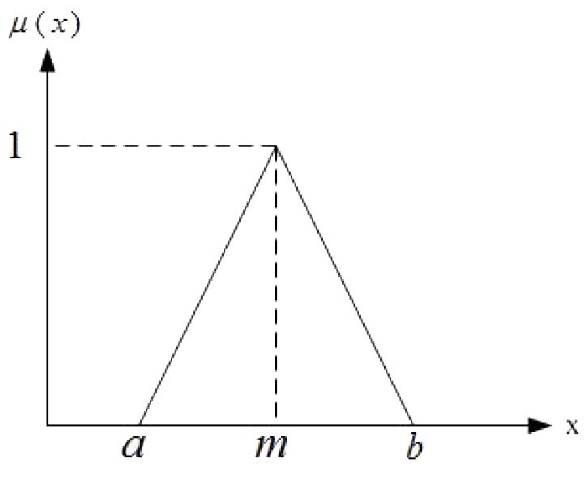
Figure 1. Presentation of fuzzy number x= ( a,m,b